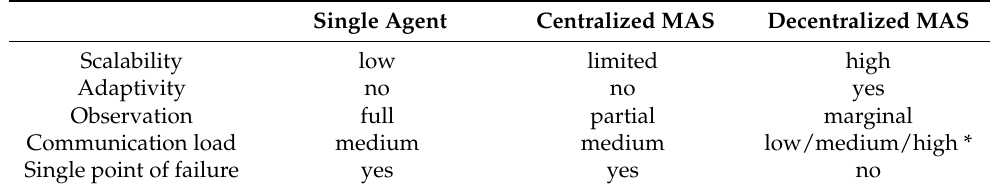
Table 1. Advantages and disadvantages of different agent system architectures.